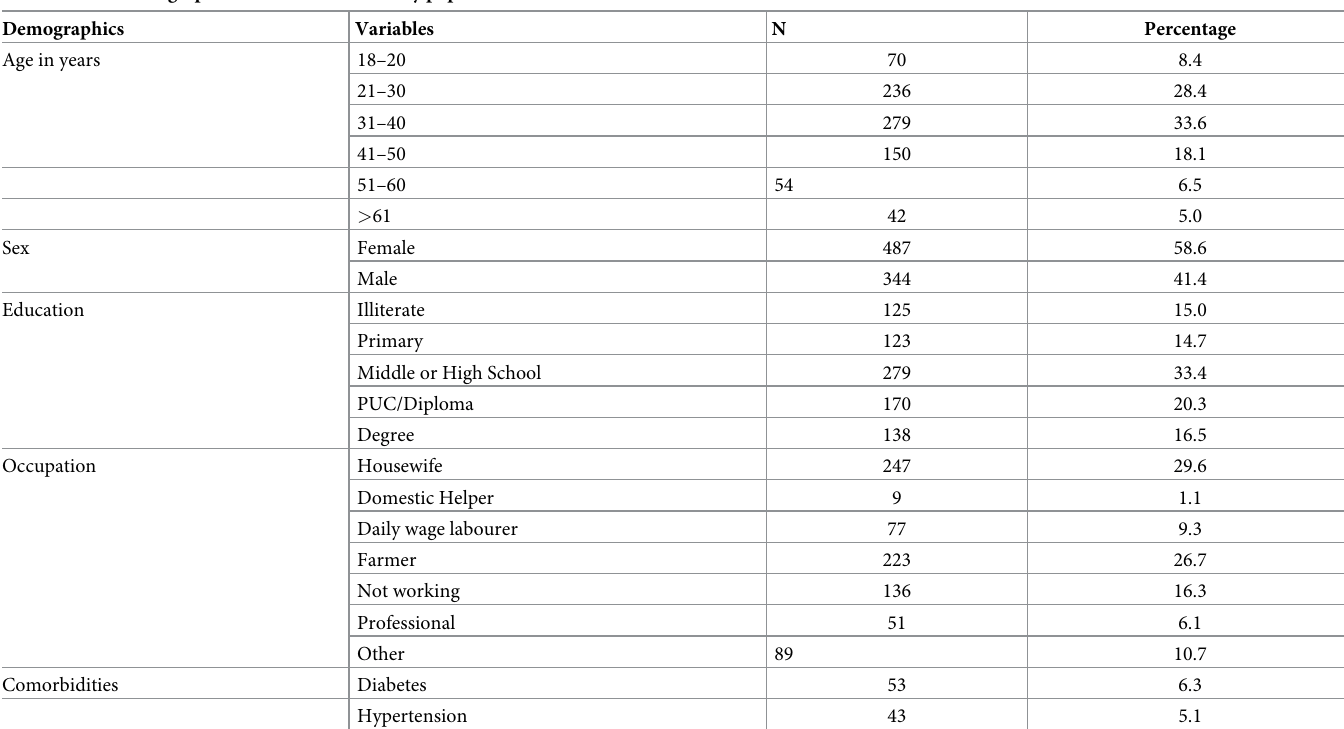
Table 1. Sociodemographic characters of the study population.